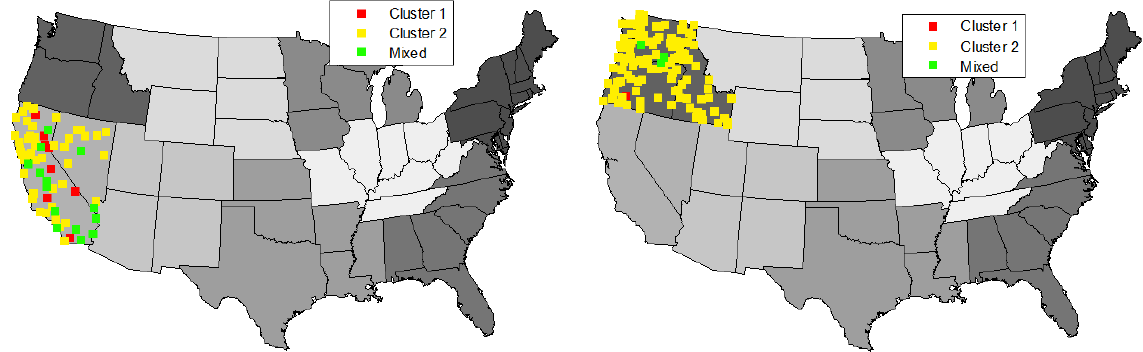
Figure 7. Left panel: location of stations and their cluster membership in the western region. Right panel: location of stations and their cluster membership in the northwestern